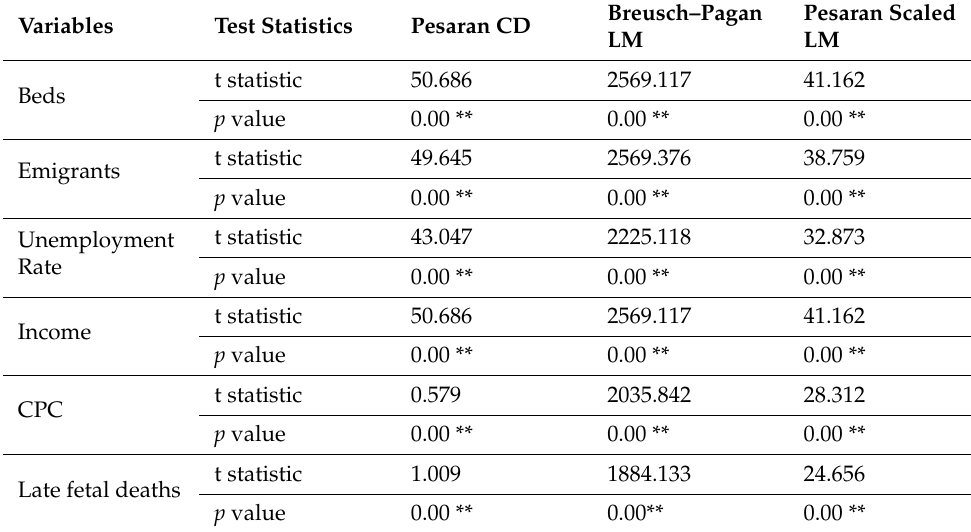
Table 2. Results of cross-sectional dependence tests.